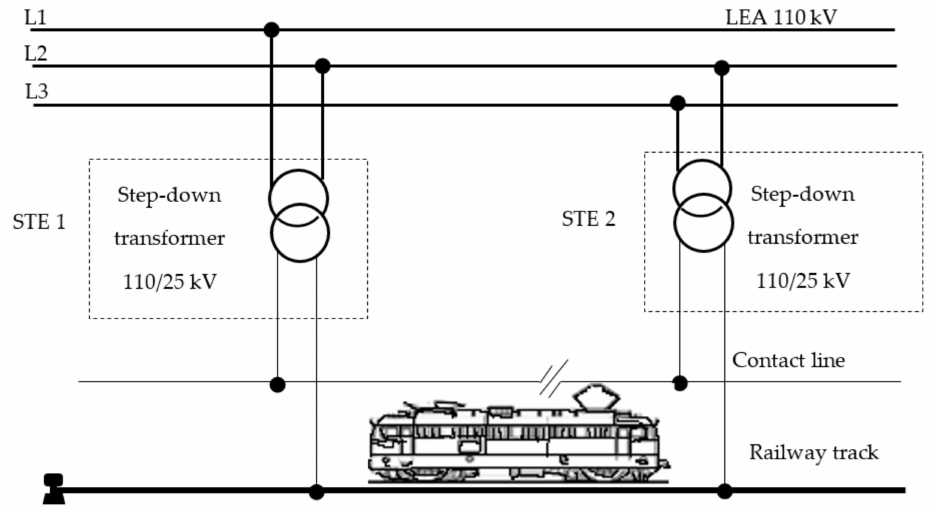
Figure 2. Schematic diagram of single-phase system with 25 kV, and 50